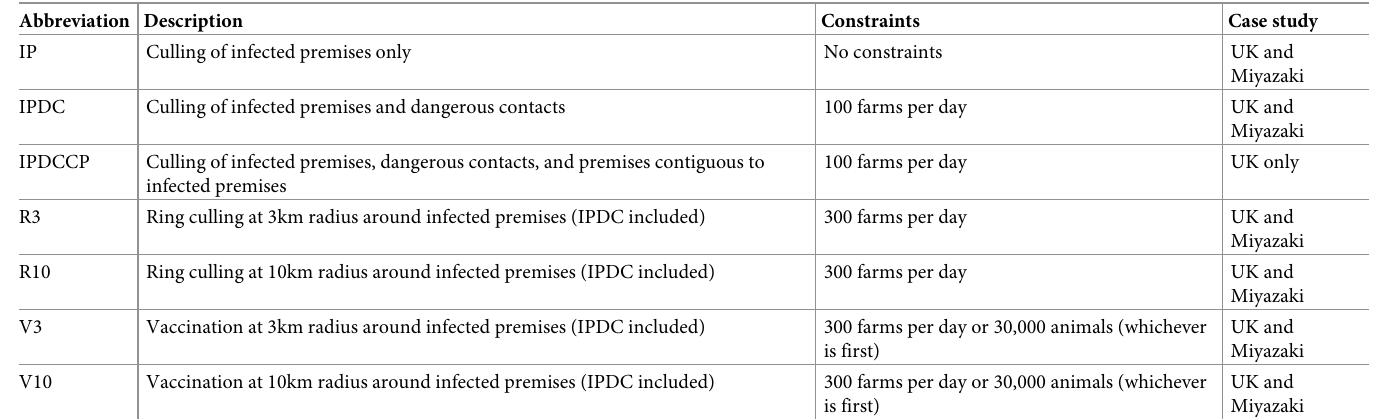
Table 1. Summary of control interventions used in the